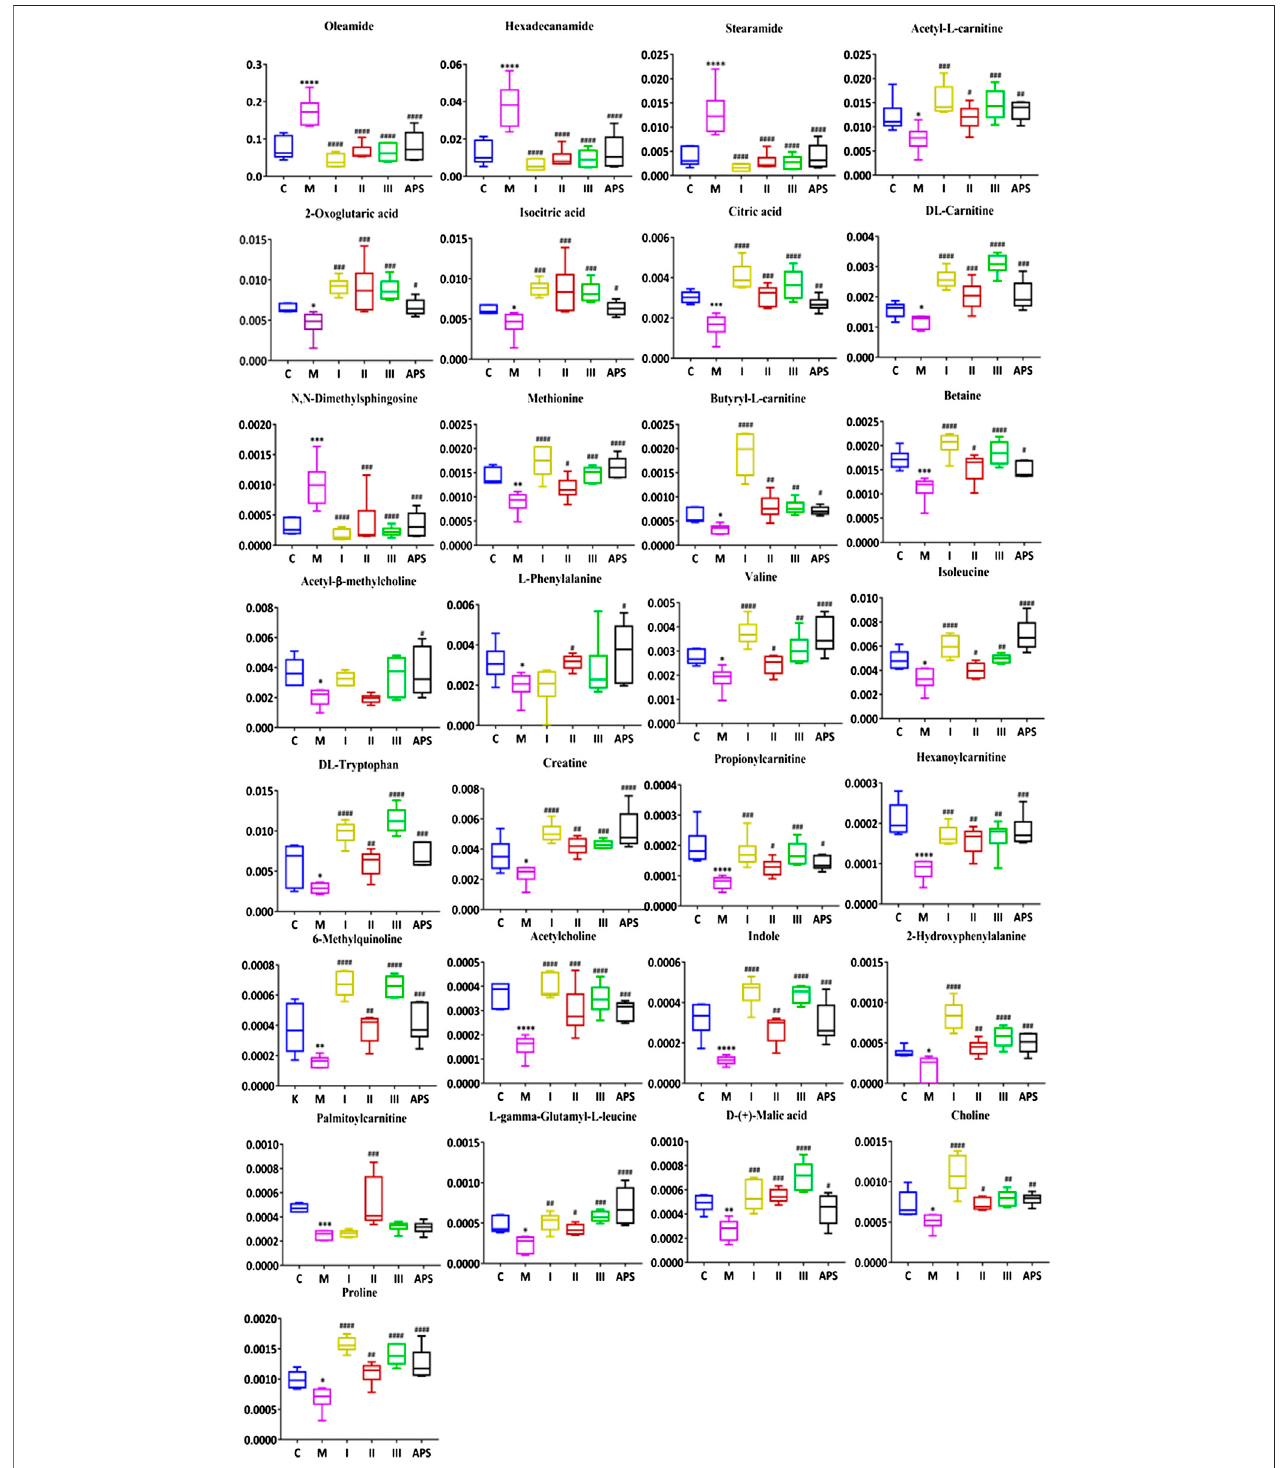
FIGURE9| Comparison ofthenormalizedpeakareasofdifferentialmetabolitesineachgroup.C:controlgroup,M:modelgroup,I:APS-I,II:APS-II,III:APS-III. n (cid:2) 6, ± s , * p < 0.05, ** p < 0.01, *** p < 0.001 vs. the control group; # p < 0.05, ## p < 0.01, ### p < 0.001 vs. the model group.